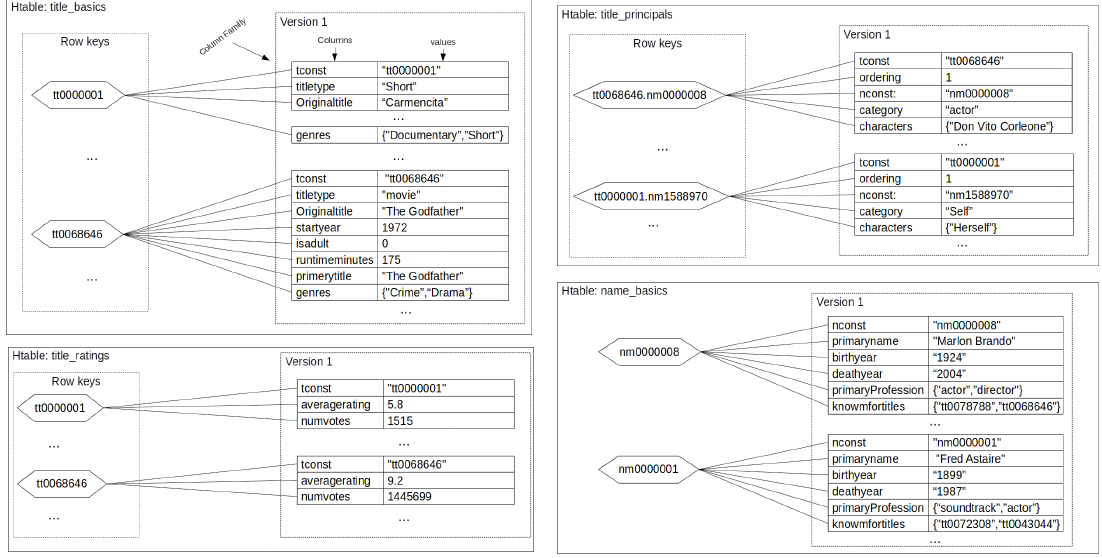
Figure 5. IMDd mapped to Apache